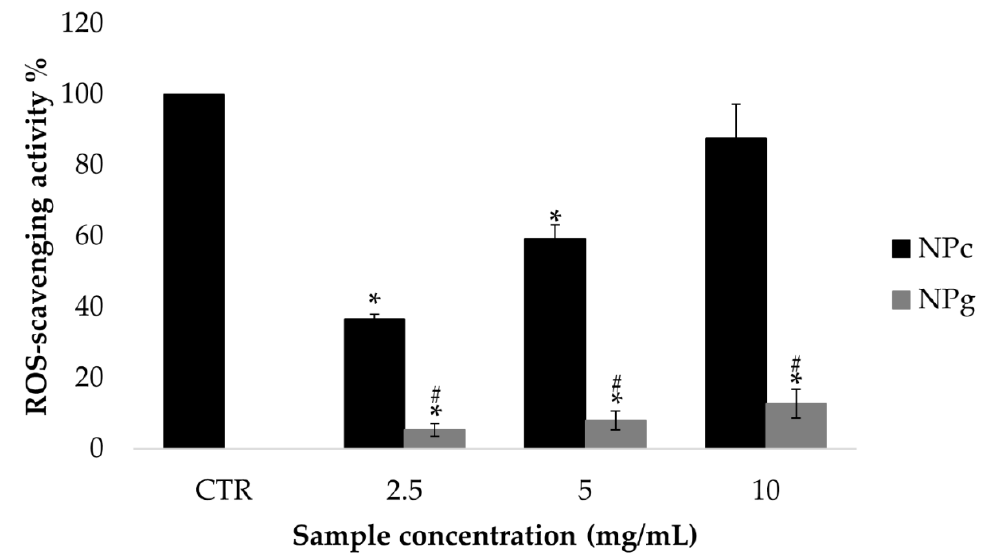
Figure 6. Reactive oxygen species (ROS) scavenging activity % as a function of nanoparticle concentrations (mg/mL). Results are reported as mean values ± standard deviation ( n = 3). Ascorbic acid, considered a positive control, presented a ROS-scavenging ability of 100% at the concentration of 1.25 mg/mL. * p < 0.05 versus CTR; # p < 0.05 versus